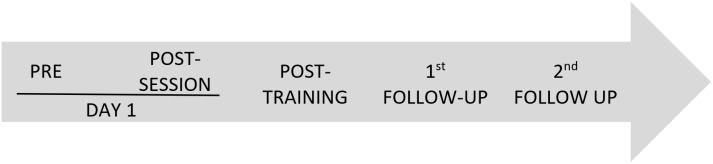
Assessment moments.